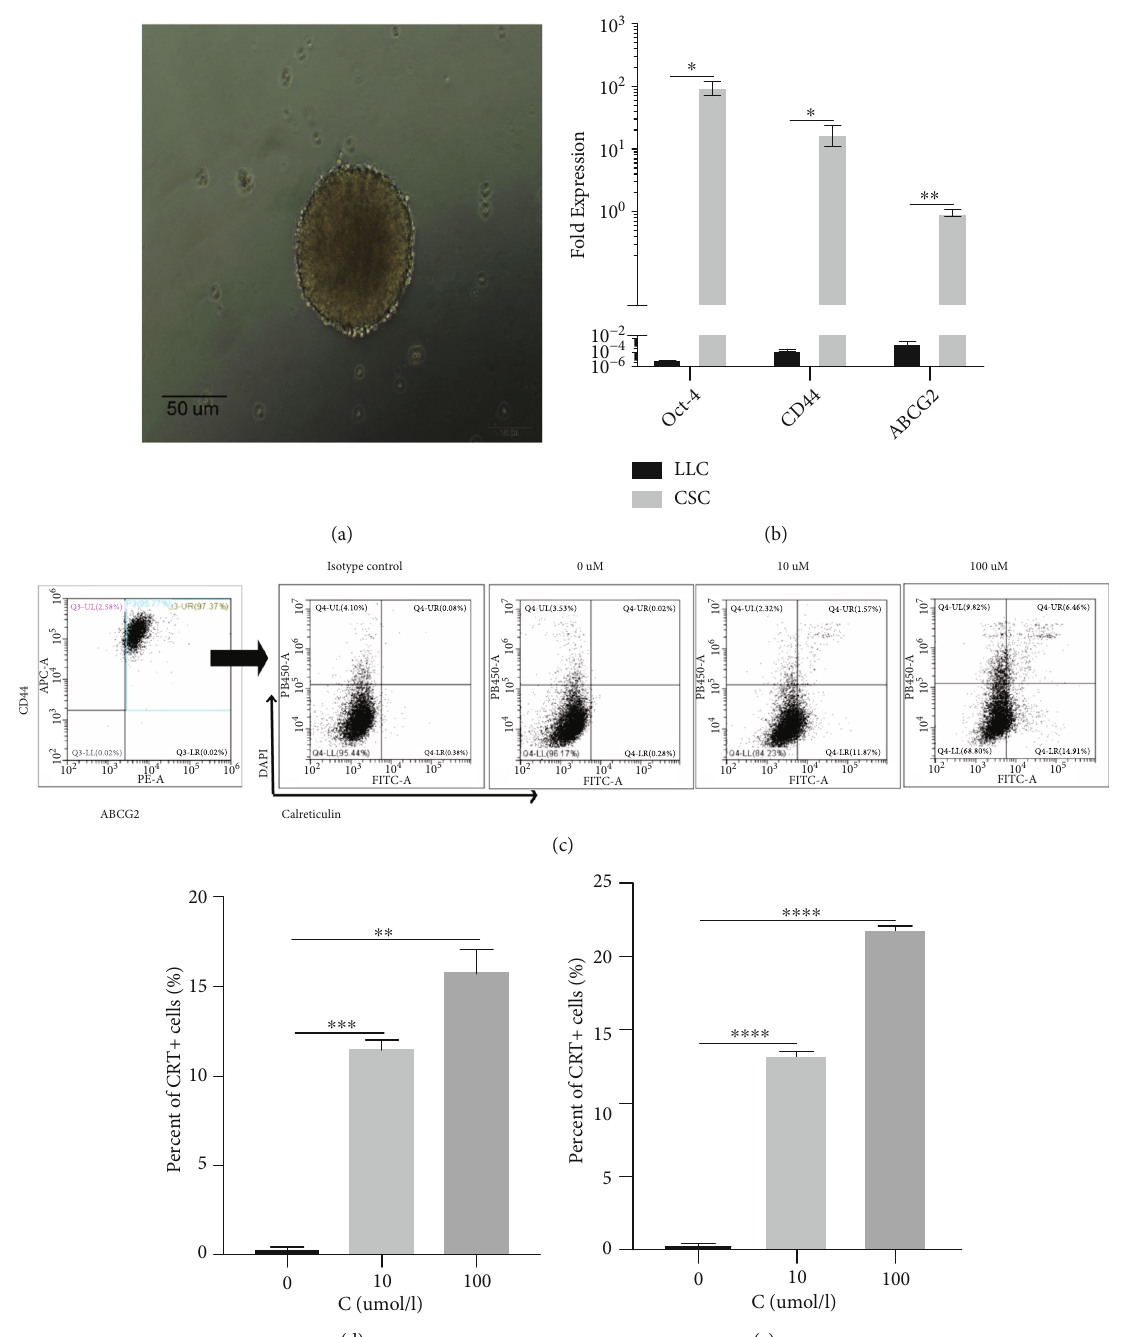
Figure 3: Lewis cancer stem cells treated with RB were exposed to calreticulin on the surface (ecto-CRT). (a) The increased size of the cell spheres after 7 days (magni fi cation of 200x). (b) The results of the real-time quantitative PCR analysis indicated that the expression of the Oct-4, CD44, and ABCG2 genes was signi fi cantly elevated in Lewis CSCs than LLCs. (c – e) The RB treatment induced increased ecto-CRT expression in CSCs in a dose-dependent manner. Increased expression was observed on both live (d) and dead cells (e) based on fl ow cytometric analysis. The gating strategy of ecto-CRT expression in cancer stem cells: First, the cells were collected, and the voltage was adjusted according to the blank control. Then, a new scatterplot was created, and the target cells were gated (cross gate) and fi nally compensated by APC, PE, FITC, and DAPI single-stained controls. A representative example of three separate experiments is summarized in (d). The mean ± SD are shown. One-way ANOVA was performed, and the signi fi cance level was de fi ned as ∗∗ P < 0 : 01 , ∗∗∗ P < 0 : 001 , and ∗∗∗∗ P < 0 : 0001